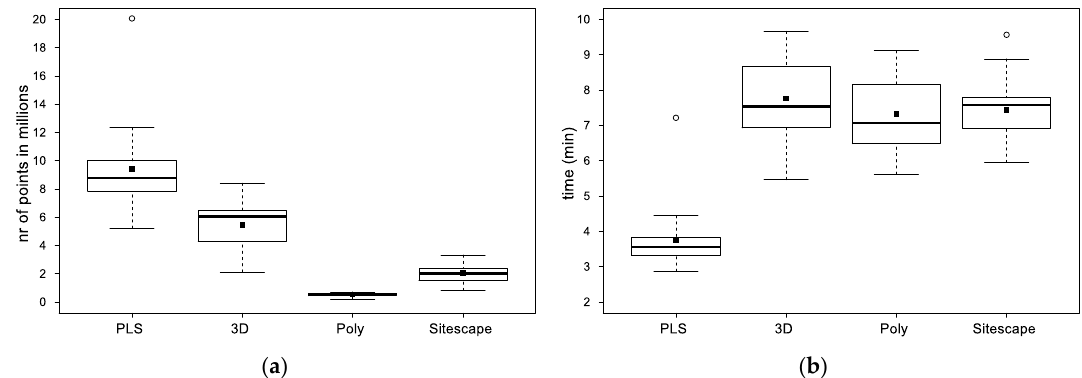
Figure 7. ( a ) Distribution of number of points for PLS/iPad. ( b ) Distribution of acquisition time for iPad/PLS. Black squares represent average values over all sample plots.